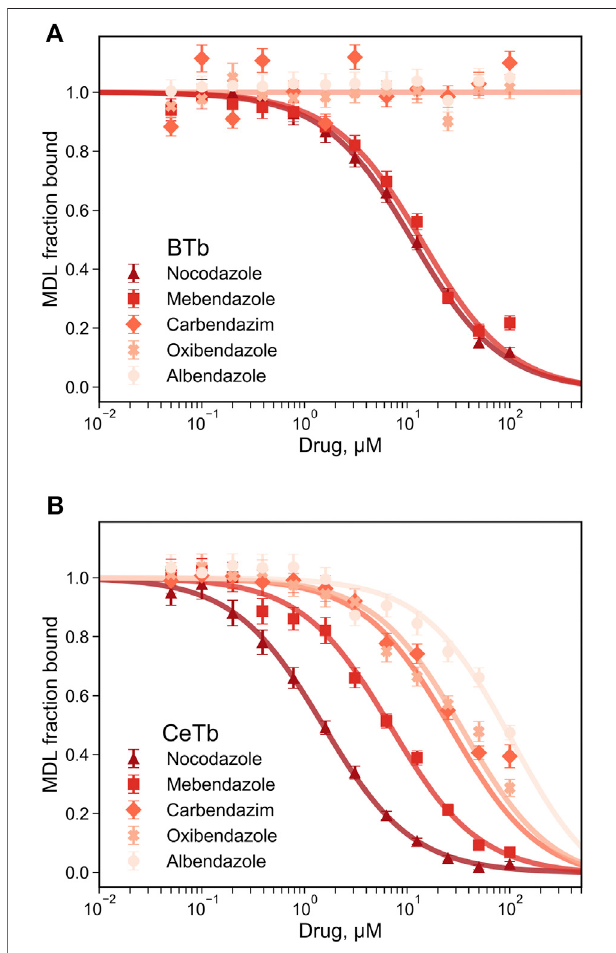
FIGURE 6 | Determination of the dissociation constant for tubulin — benzimidazoles interaction by competition experiments. The fl uorescence of tubulin-bound MDL gradually decreases upon displacement by the benzimidazoles competitors. Fluorescence was monitored at 550 nm with excitation at 400 nm, for tubulin from brain (A) or from erythrocytes (B) . The reaction mixtures contained 1 µM tubulin with 5 µM MDL incubated in PM buffer at room temperature at the indicated drug concentrations. The data points are the average of three to four measurementsandtheerrorbarsarestandarddeviations.Thebest- fi tK d with the standard errors of the fi ts are shown in Table 3 .